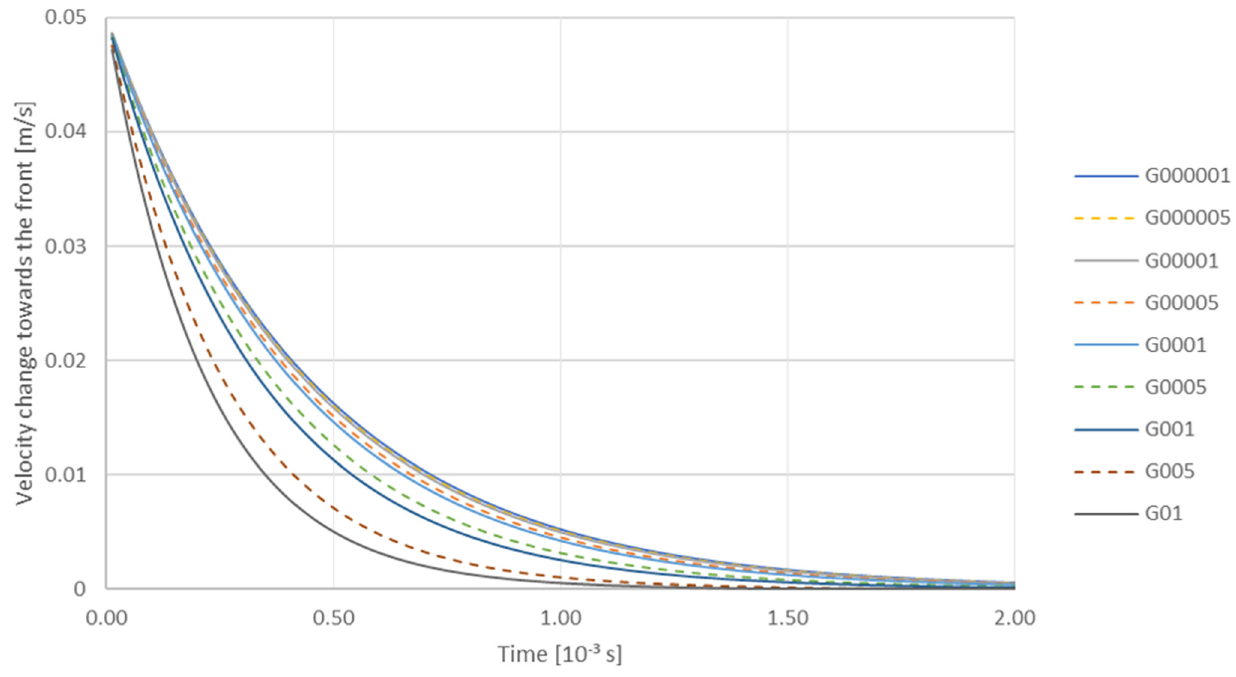
Figure 10. Analysis of influence of gradient on the change of velocity of a TiC particle with a radius of 7.75 × 10 − 8 m towards the front under the viscosity conditions of 0.0015 Pa · s. Gradient, m/s: G000001—0.00001; G000005—0.00005; G00001—0.0001; G00005—0.0005; G0001—0.001; G0005—0.005; G001—0.01; G005—0.05; G01—0.1.